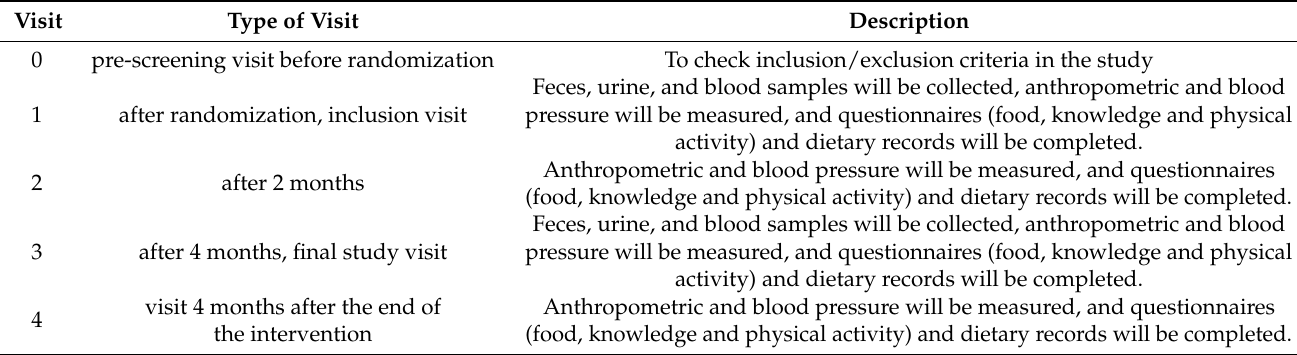
Table 3. Description of study